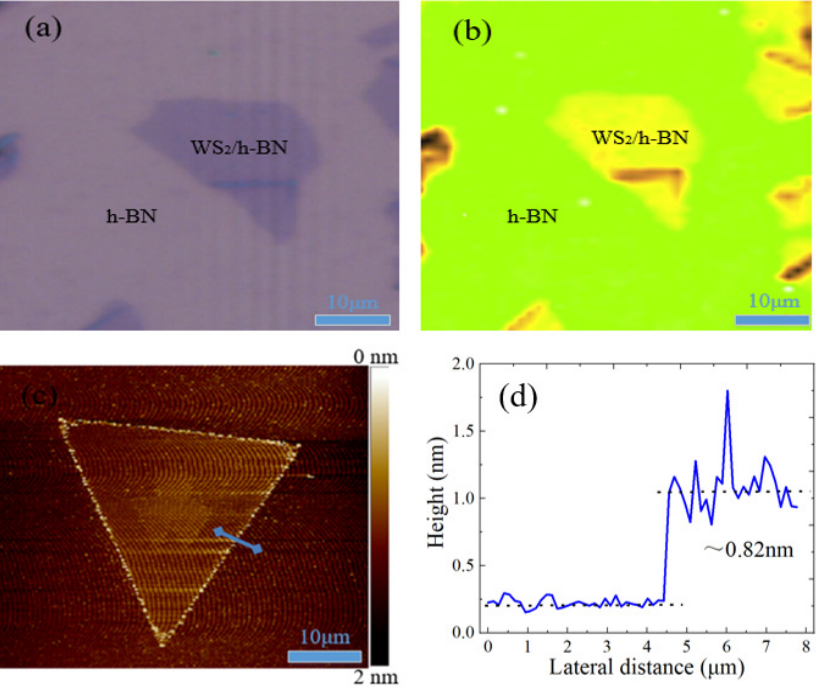
Figure 8. ( a ) Optical micrograph, ( b ) Raman spectrum mapping, ( c ) AFM and ( d ) height profile of WS 2 /h-BN heterostructure on SiO 2 /Si